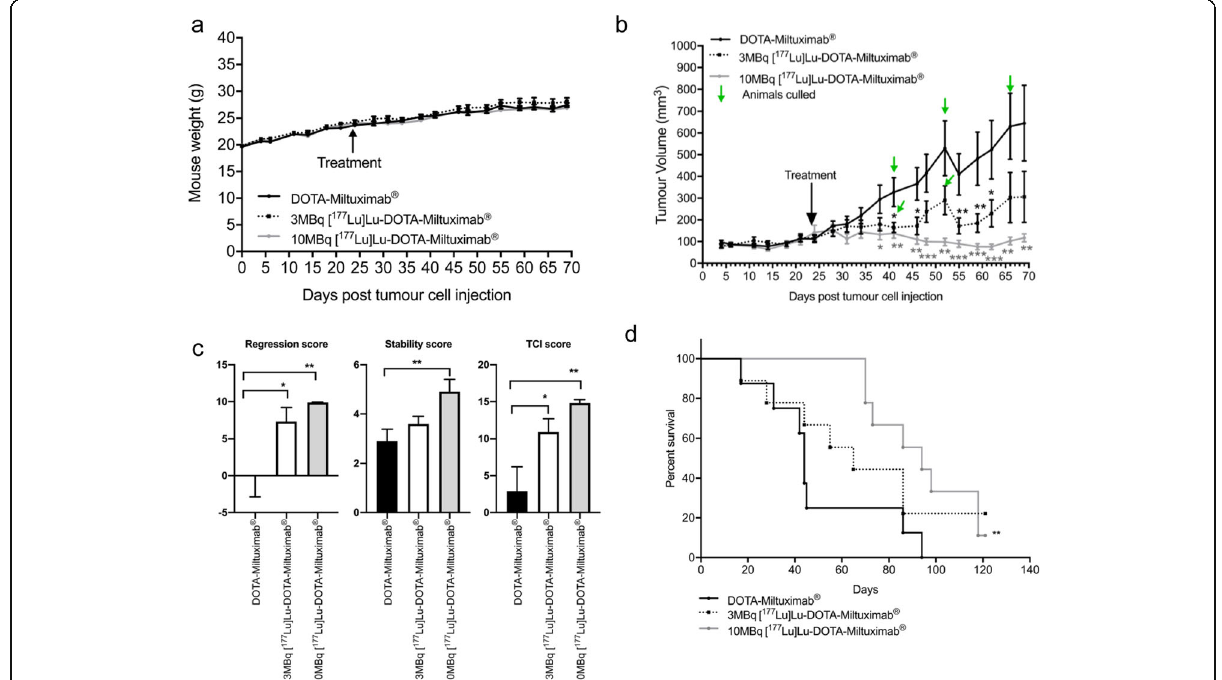
Fig. 4 Dose-dependent inhibition of tumour growth by [ 177 Lu]Lu-DOTA-Miltuximab®. DU-145-RFP-Luc cells (5 × 10 6 in Matrigel) were injected subcutaneously into the right flank of BALB/c/nude mice. On day 25, the mice received either DOTA-Miltuximab® ( n = 8), 3 MBq [ 177 Lu]Lu-DOTA- Miltuximab® ( n = 9) or 10 MBq [ 177 Lu]Lu-DOTA-Miltuximab® ( n = 9) intravenously. Mice were weighed and tumour volumes measured via callipers twice weekly. a Mean mouse weight over time. b Mean weekly mouse tumour volume. * p < 0.05; ** p < 0.01; *** p < 0.001 by one-way